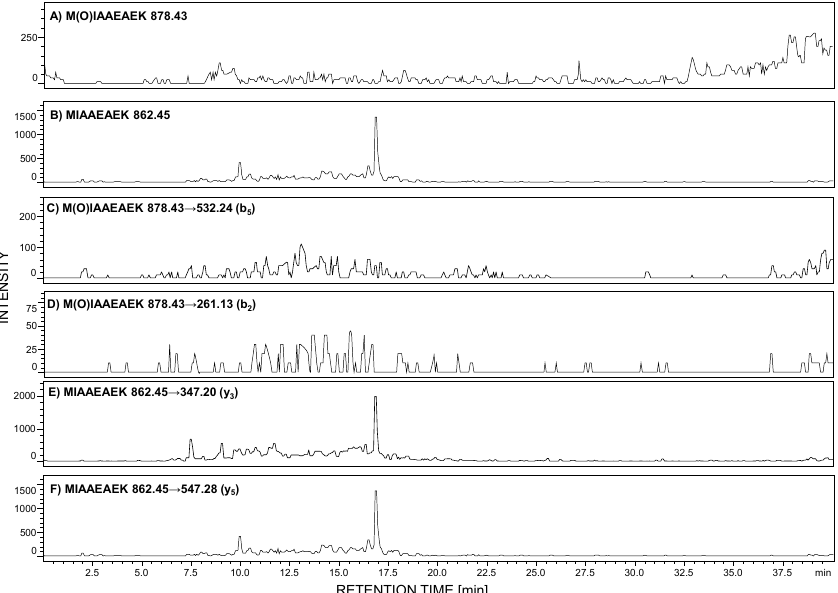
Figure 3. Selected ion monitoring of M(O)IAAEAEK ( A ) and MIAAEAEK ( B ) peptide sequences in urine sample tryptic digest from patient with diagnosed preeclampsia (PE). MRM investigation of M(O)IAAEAEK ( C , D ) and MIAAEAEK ( E , F ) peptide sequences in urine sediment tryptic digest from pregnant women with diagnosed preeclampsia. MRM transitions corresponding to the oxidized peptide with the M(O)IAAEAEK sequence were not